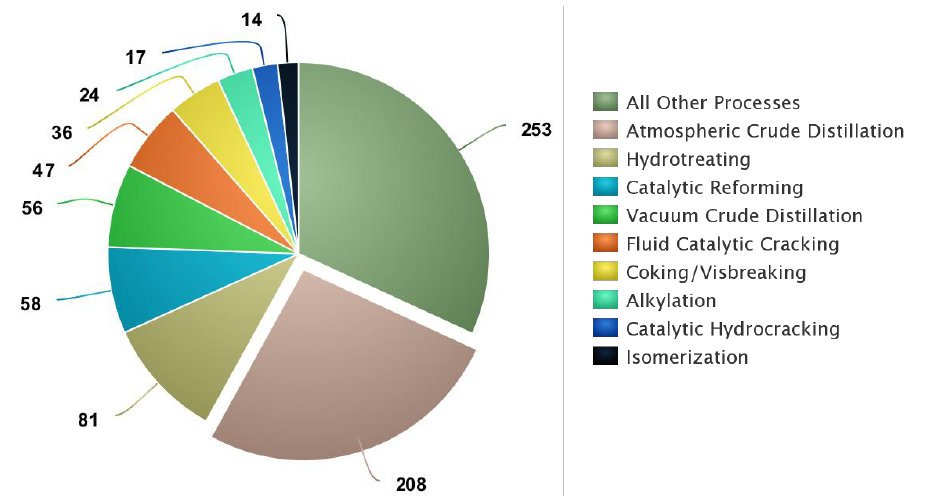
Figure 1. Potential of energy savings in petroleum refineries (energy savings per annum in trillion BTUs) [1].